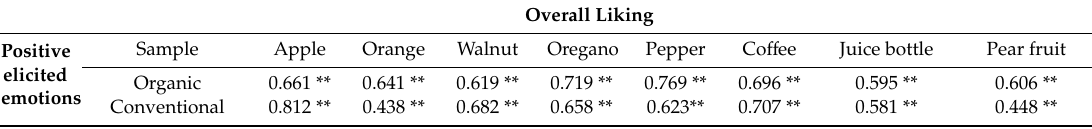
Table 4. Spearman’s correlation measures the strength of association between overall liking and positive elicited